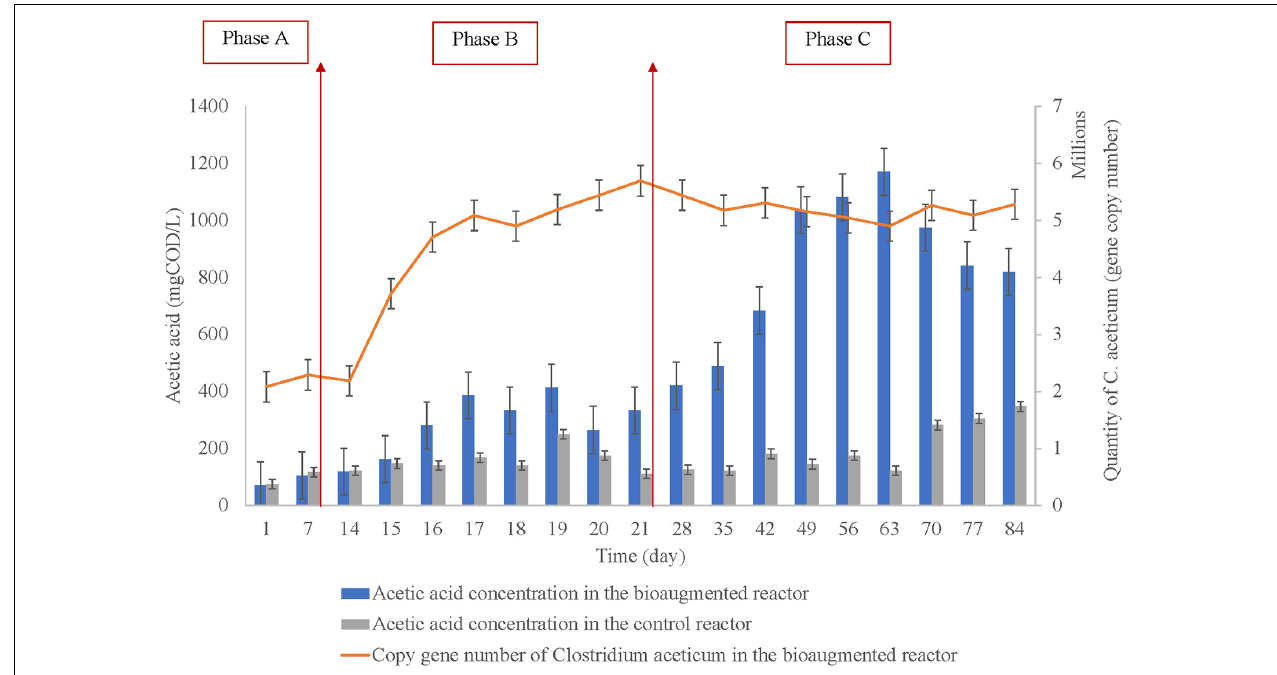
FIGURE 2 | The acetic acid concentration in the control and the bioaugmented set and quantification of Clostridium aceticum in the bioaugmented set (Phase A: before bioaugmentation; Phase B: during bioaugmentation, and Phase C: after